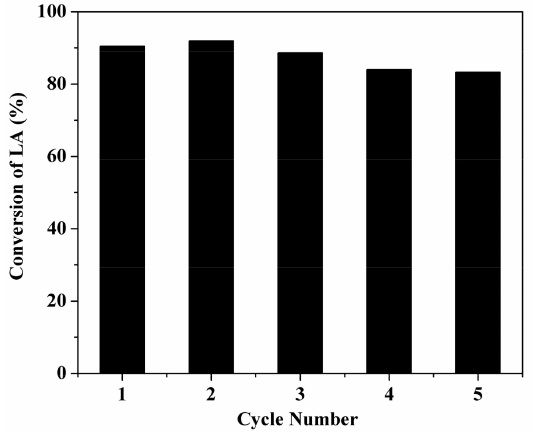
Figure 7. Stability test of GC400. Reaction conditions: 1.16 g LA, 3.7 g n-butanol, 0.116 g catalyst, 373 K, 4